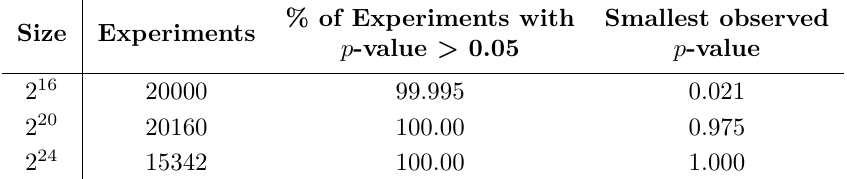
Table 2: Results of the Pearson χ 2 test of independence for various permutation sizes. A p -value larger than 0.05 indicates that the correlations of two linear approximations are statistically independent at the 95% significance